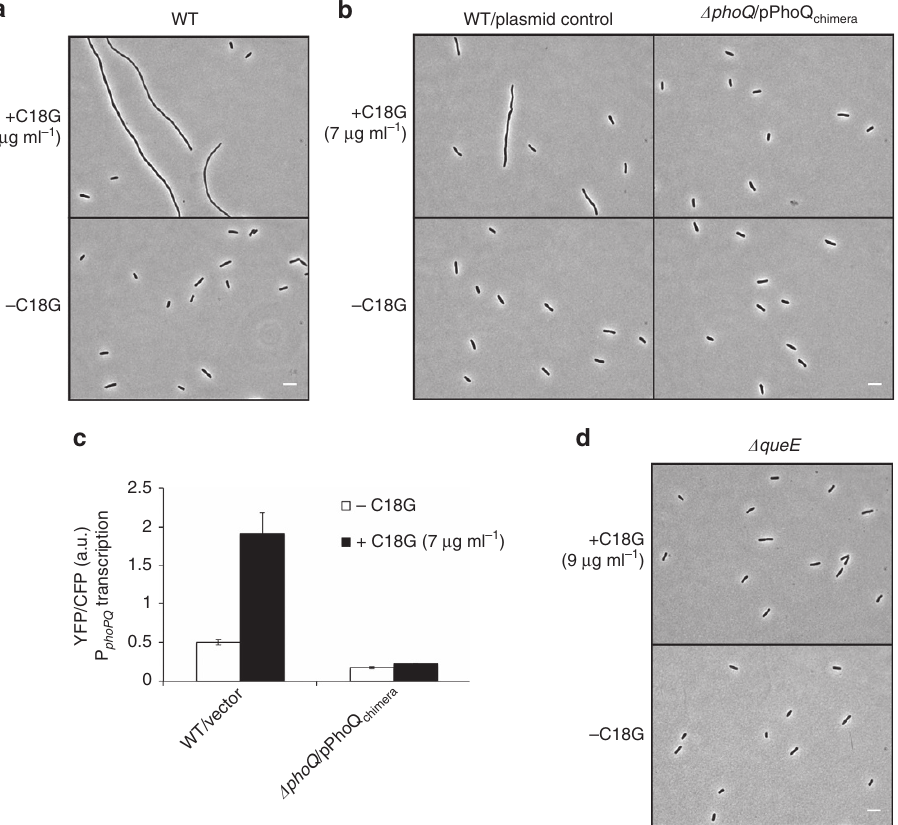
Figure 1 | Antimicrobial peptide stimulation of the E. coli PhoQ/PhoP system causes cells to filament. ( a ) Phase-contrast micrographs of wild-type (MG1655) cells grown in the presence or absence of C18G. ( b ) Phase-contrast micrographs of wild-type cells containing control vector (TIM148/pGB2) and D phoQ cells containing a plasmid encoding PhoQ chimera (TIM229/pLPQ*2) grown in the presence or absence of C18G. ( c ) Measurement of phoPQ promoter activity (which is regulated by PhoP-P) from a P phoPQ - yfp transcriptional reporter in wild-type cells containing control vector (TIM148/pGB2) and D phoQ cells containing a plasmid encoding PhoQ chimera (TIM229/pLPQ*2) grown in the presence or absence of C18G. PhoQ chimera , which is not stimulated by C18G but has a basal level of PhoQ activity, was used to avoid the high toxicity of C18G in D phoQ strains. (See text for details.) Data represent means and s.d.’s from at least three independent experiments. ( d ) Phase-contrast micrographs of D queE cells (SAM96) grown in the presence or absence of C18G. Cells were grown in minimal medium containing 0.1mM Mg 2 þ and the indicated concentration of C18G to an OD 600 ¼ 0.2–0.3 and imaged by microscopy. Scale bar, 5 m